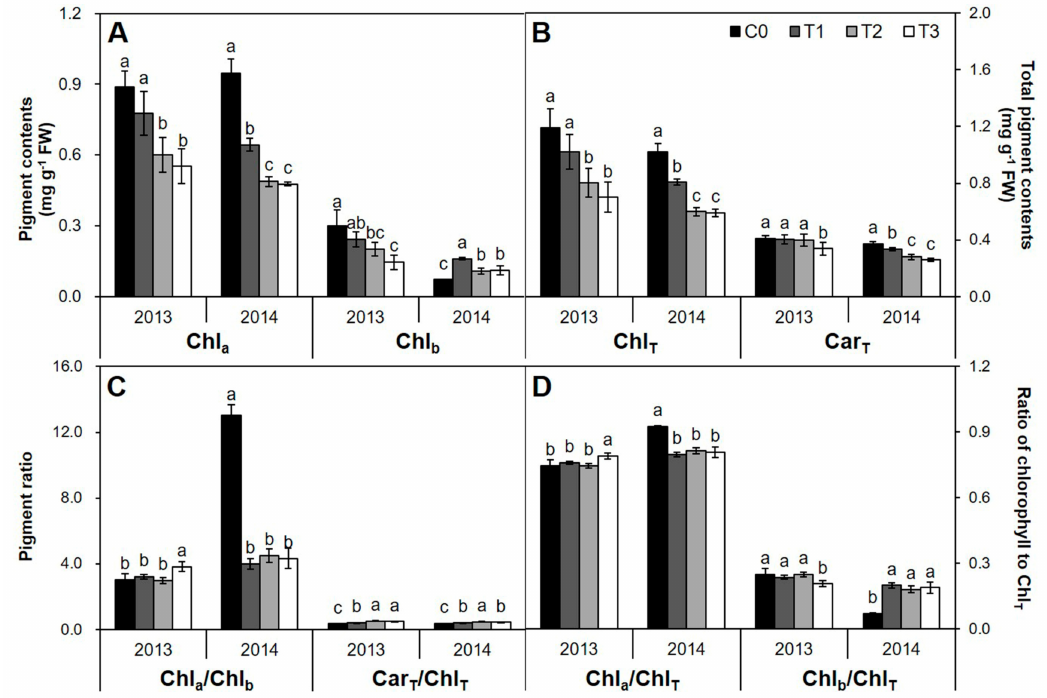
Figure 1. Pigment contents (( A ), Chl a and Chl b ), total pigment contents (( B ), Chl T and Car T ), pigment ratio (( C ), Chl a /Chl b and Car T /Chl T ), and ratio of Chl a or Chl b to Chl T (( D ), Chl a /Chl T and Chl b /Chl T ) in yellow-poplar leaves exposed to the natural day/night cycle (C0, black bars) and the day/night with artificial lighting cycle (T1, T2, and T3 denote dark gray bars, light gray bars, and white bars, respectively). Data indicate the mean ± SD ( n = 5). Different lowercase letters on the bars indicate significant differences among treatments in 2013 and 2014, respectively (Tukey’s test after one-way ANOVA); FW = fresh